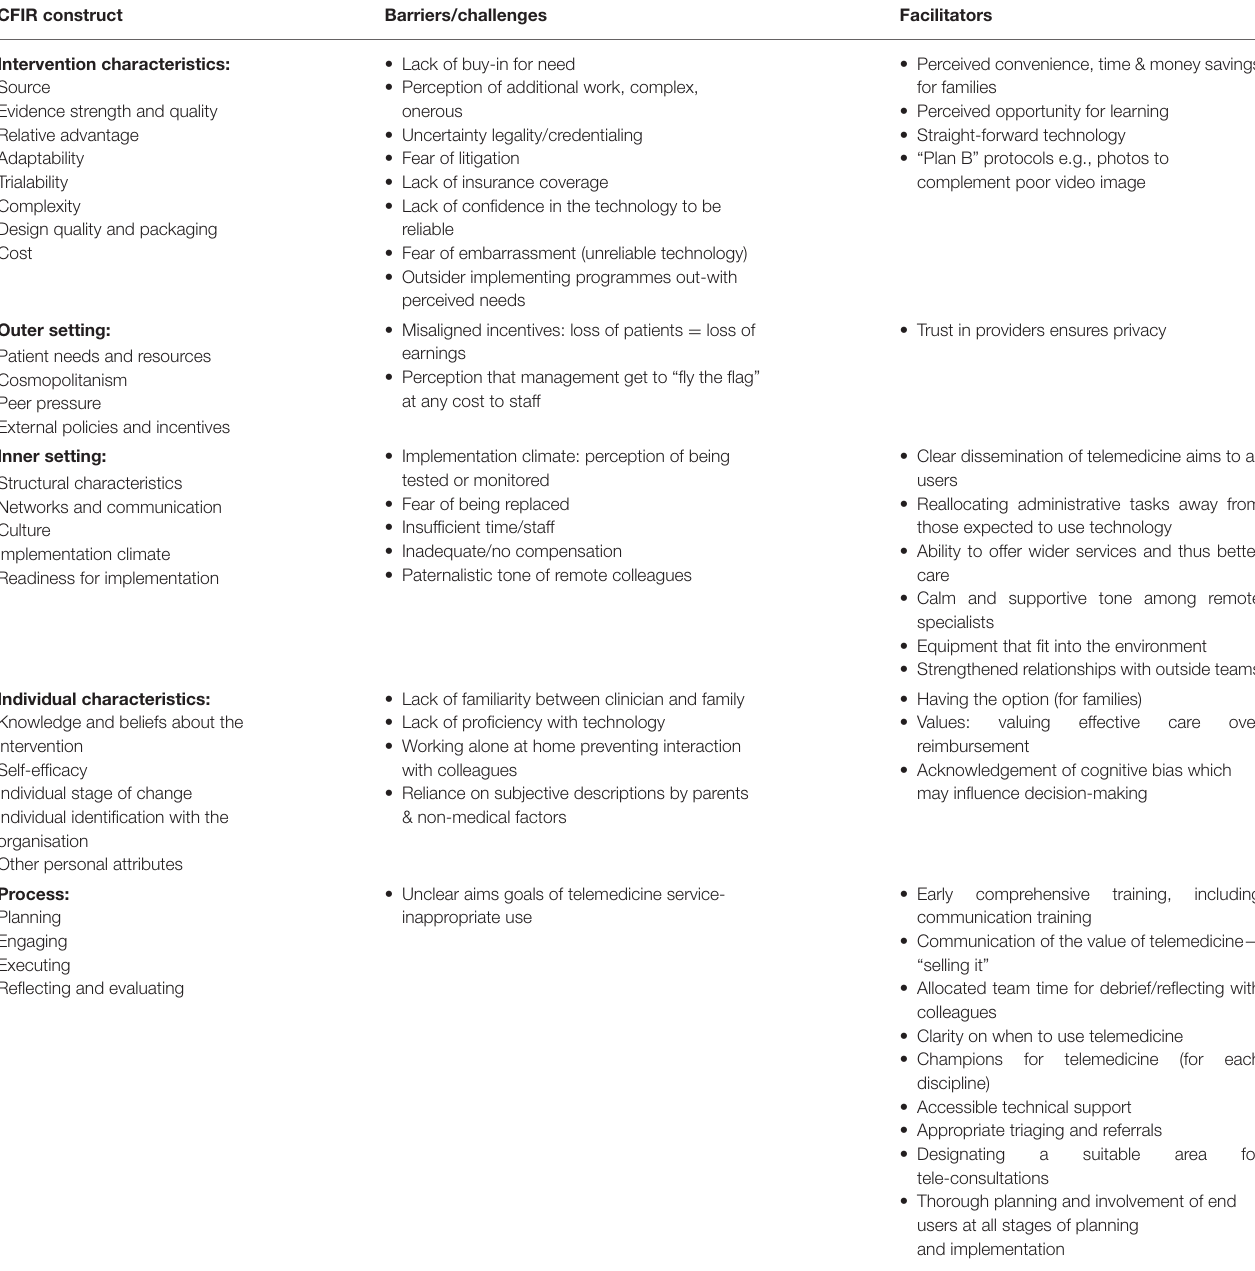
TABLE 1 | Summary of barriers and facilitators for implementation of telemedicine assessed qualitatively. CFIR